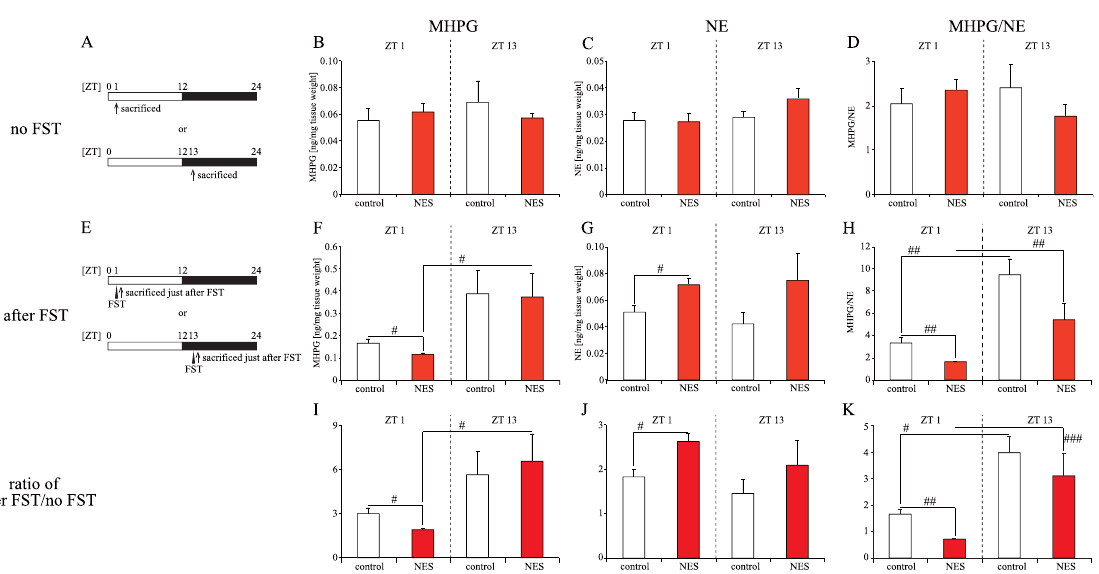
Figure 7. Effect of 5-min RF with HFD at ZT 5 on NE secretion and metabolism in the hippocampus at ZT 1 and 13 with and without FST (Experiment 6). ( A ) Sampling schedules. Mice were sacrificed at ZT 1 or 13 without FST, after mice were kept on each feeding condition for 4 weeks (no FST). ( B – D ) MHPG ( B ), NE ( C ), and the metabolic rate (MHPG/NE; D ) levels in the hippocampus at ZT 1 and 13. ( E ) Sampling schedules. Mice were sacrificed at ZT 1 or 13 just after the FST, after mice were kept on each feeding condition for 4 weeks (after FST). ( F - H ) MHPG ( F ), NE ( G ), and the metabolic rate ( H ) levels in the hippocampus at ZT 1 and 13 after the FST. ( I - K ) Stress reactivity of MHPG ( I ), NE ( J ), and metabolic rate ( K ) in the hippocampus. We calculated these levels by dividing each level after FST by the average with no FST. Data are presented as the mean ± SEM ( n = 6–8). # p < 0.05, ## p < 0.01, ### p < 0.001 (Mann-Whitney